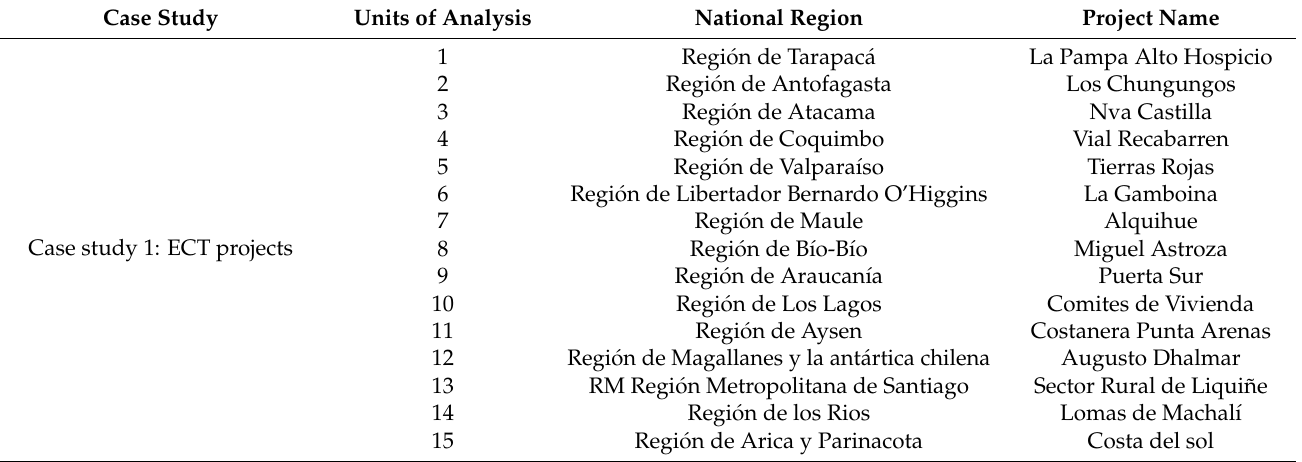
Table 2. Units of